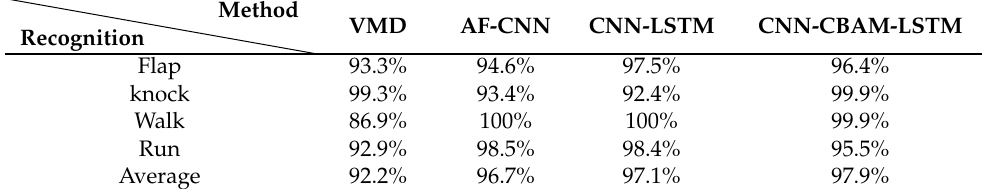
Table 3. Comparison of different